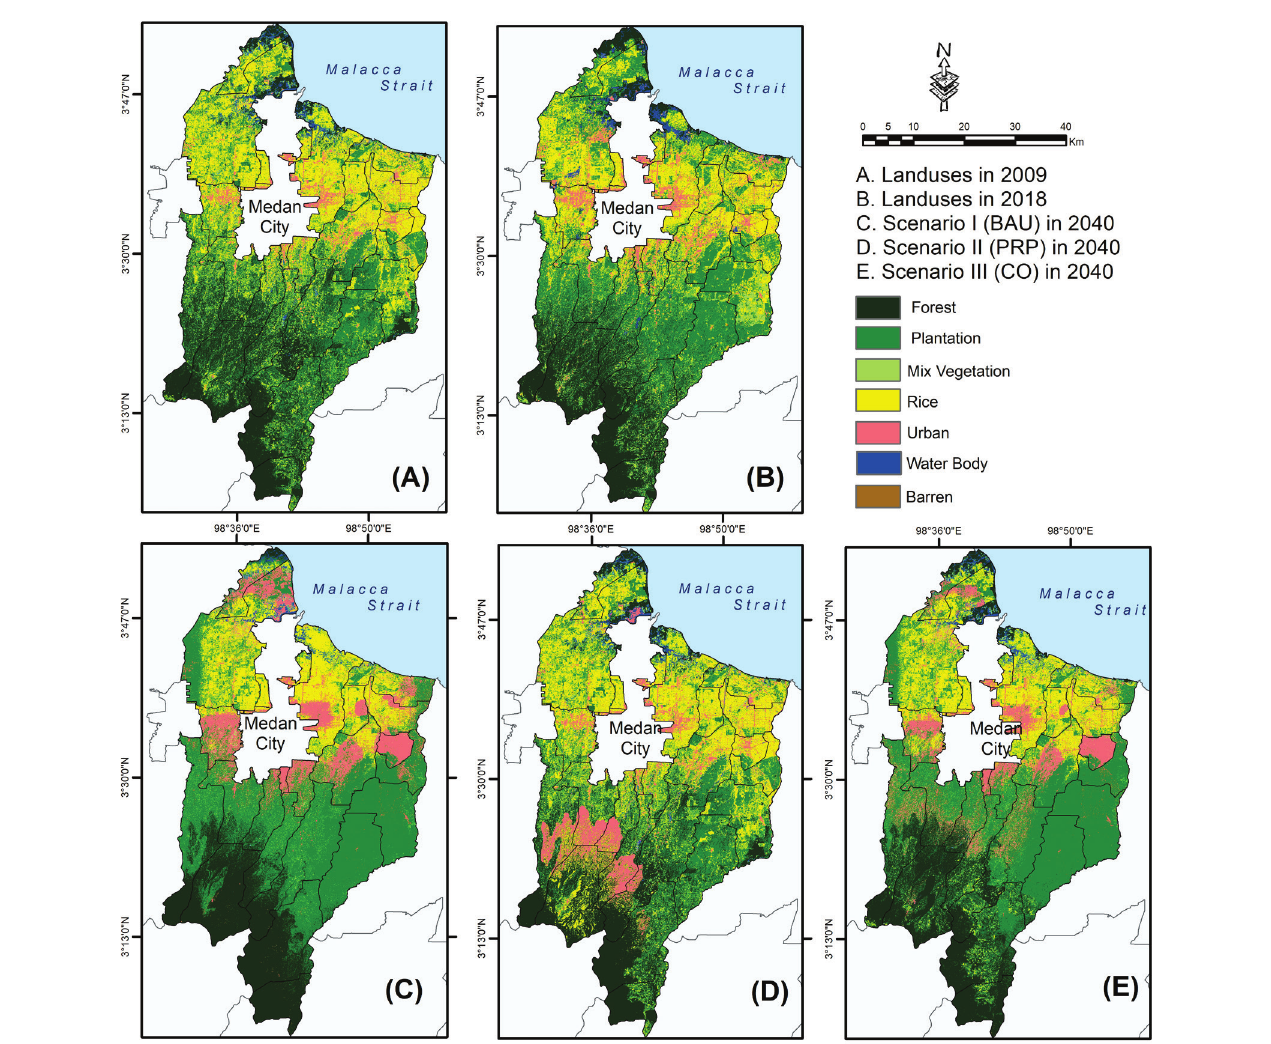
Figure 6. The classified landuse map of 2009 (A) and 2018 (B) and the simulated landuse map for 2040 at BAU (C), PRP (D) and CO (E)